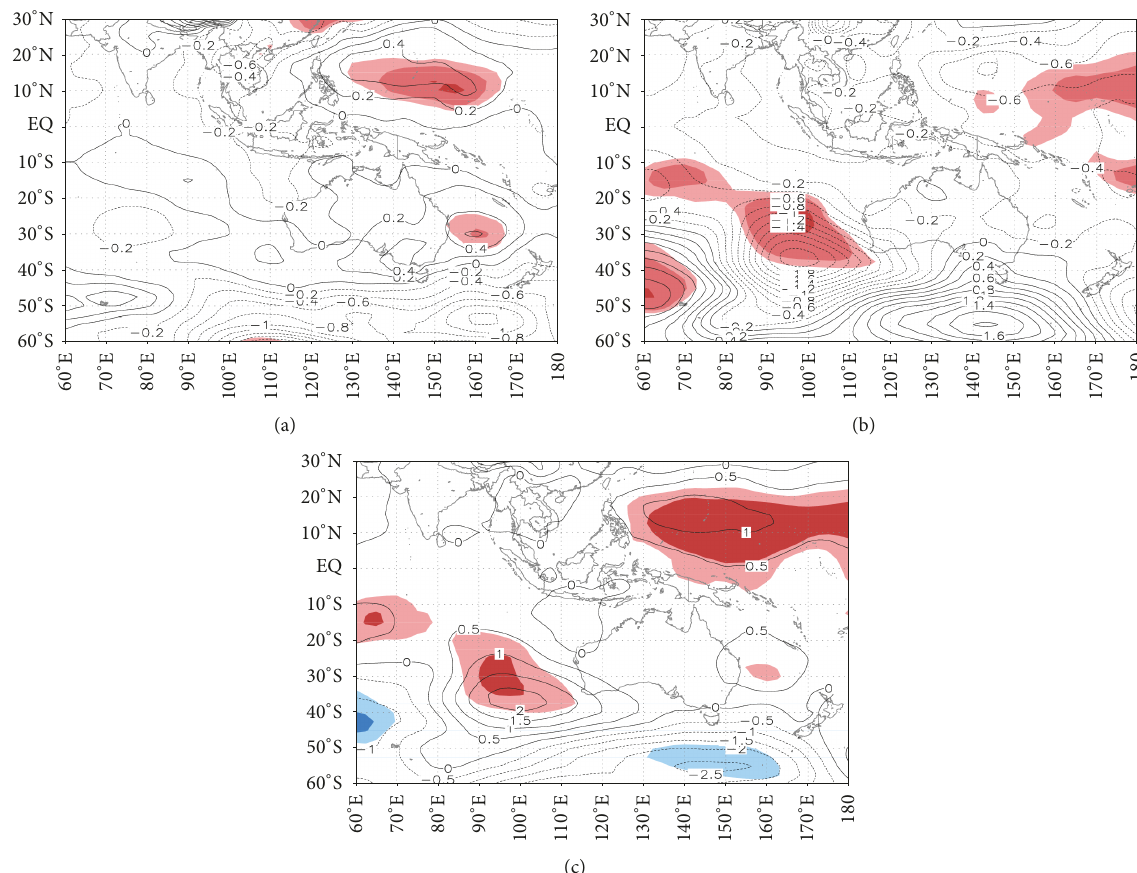
Figure 5: Composite distributions of the SLP anomalies in flood years (a) and drought years (b). Panel (c) shows the 𝑡 -test results of the 𝐷 -values between the flood and drought years. Significant values exceeding the 90%, 95%, and 99% confidence levels ( 𝑡 -test) are shaded.